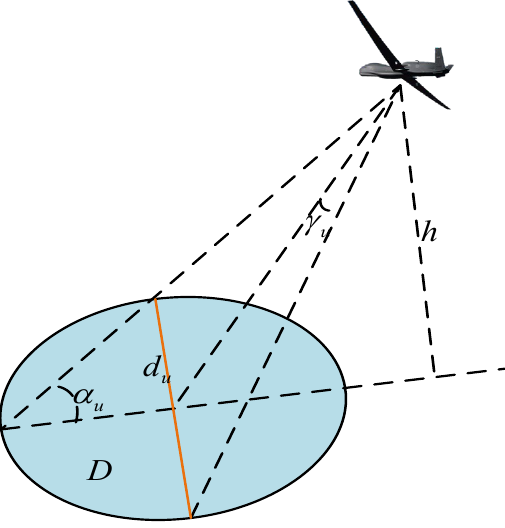
Figure 3. Airborne magnetic sounder detection model.